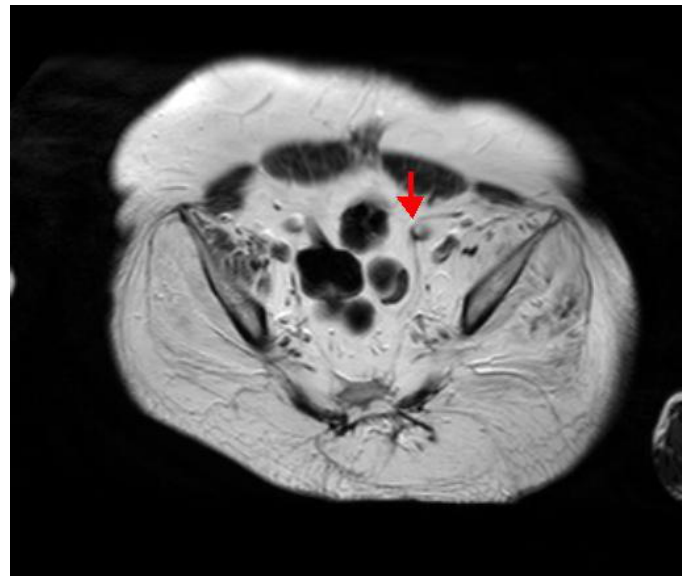
FIGURE 6. Axial T-2 weighted image demonstrating the course of the left vas deferens crossing and kinking the lower ureter at the site of incomplete obstruction